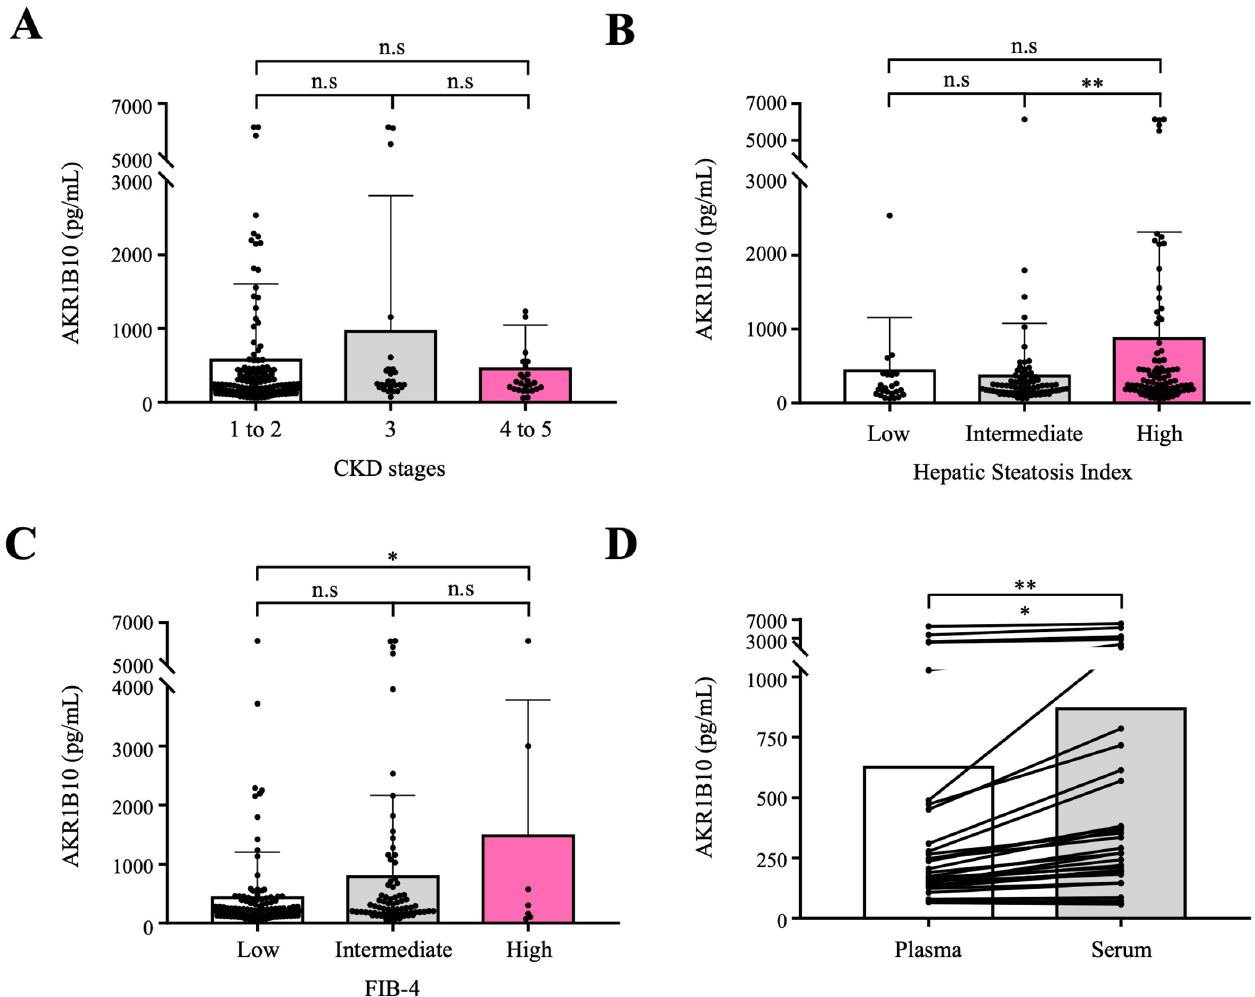
Figure 5. Validation of plasma AKR1B10 as a NAFLD progression marker in an independent cohort with a broad range of eGFRs. ( A ) Plasma AKR1B10 levels according to CKD status ( n = 195). ( B ) and ( C ) Plasma AKR1B10 levels according to the likelihood of hepatic steatosis and advanced fibrosis based on HSI and FIB-4 score systems ( n = 195). ( D ) Comparison of paired plasma and serum measurements of AKR1B10 in selected patients across a range of eGFRs. *— p < 0.05; **— p < 0.01; and n.s.—not significant.